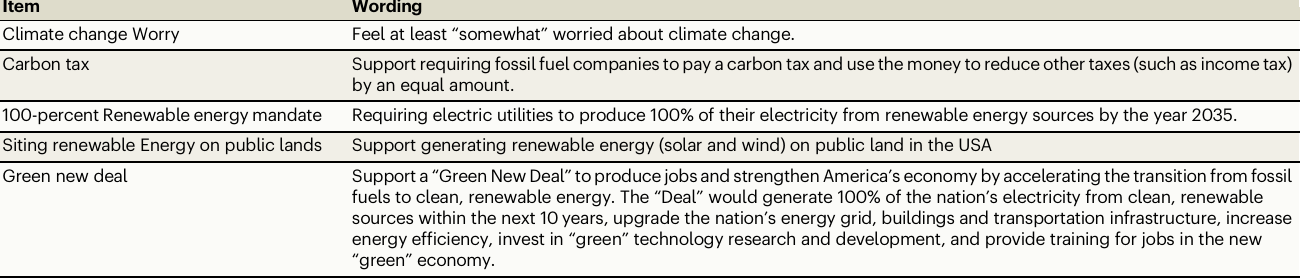
Table 2 | Norm items: what percent of Americans hold the following opinions? Item Wording Climate change Worry Feel at least “ somewhat ” worried about climate change.